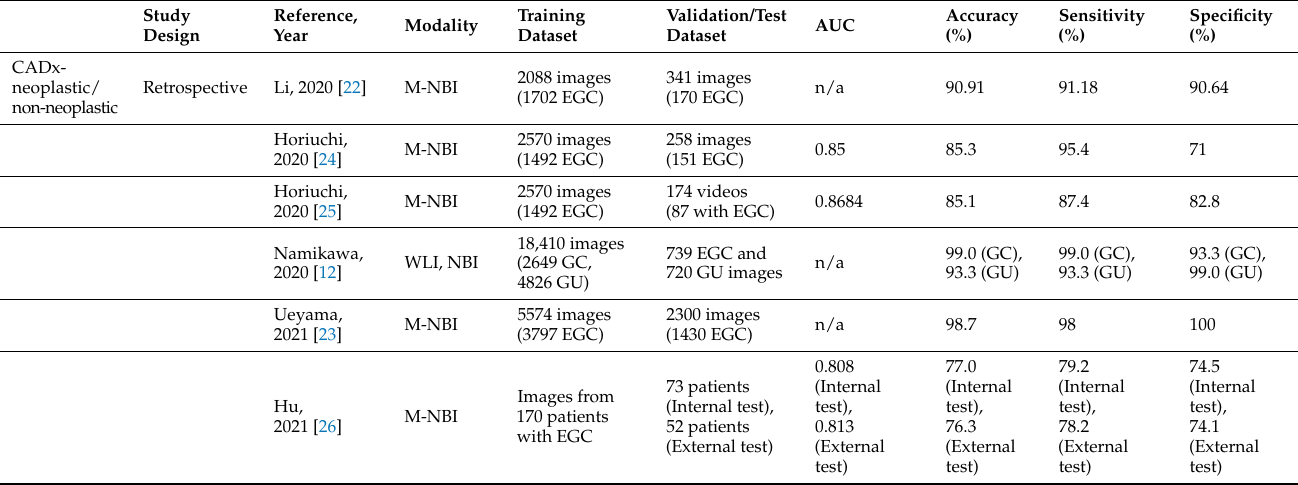
Table 2. Summary of CADx in gastric